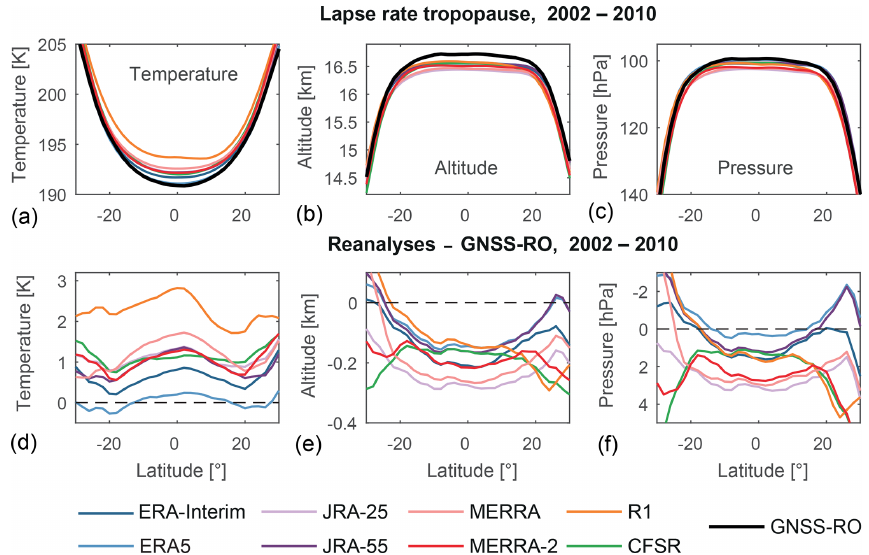
Figure 8. Latitudinal distributions of zonal-mean lapse rate tropopause temperature (a) , altitude (b) , and pressure (c) based on radio occulta- tion data and reanalysis products during 2002–2010 (a–c) . Differences between radio occultation and reanalysis estimates are shown in the panels (d) – (f)